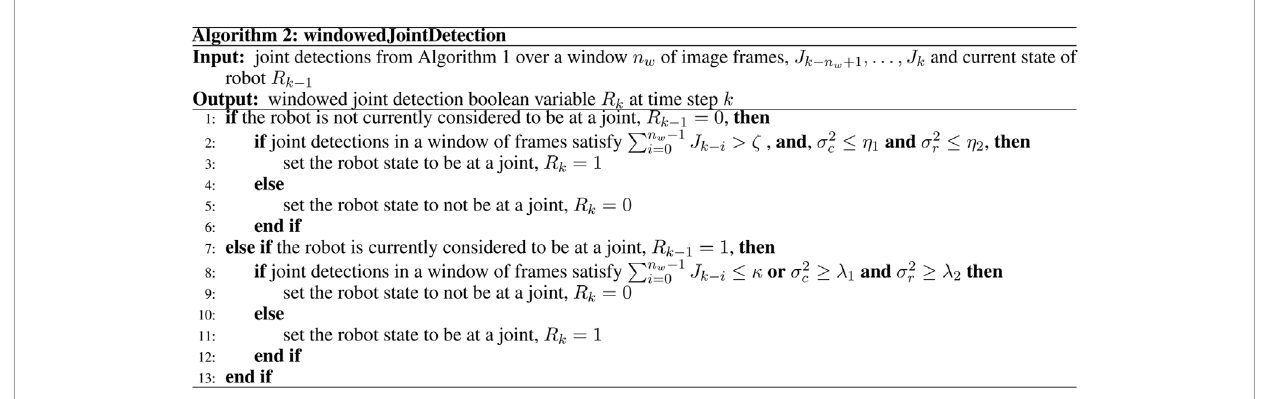
FIGURE 5 Algorithm 2: Detecting a joint in a window of